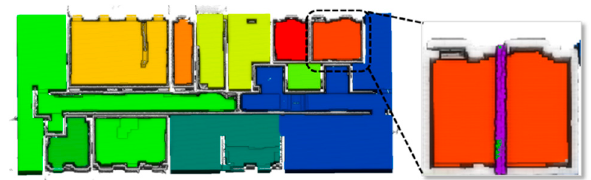
Figure 9. The space subdivisions of PC2 (second epoch) after the change. The purple wall in the right image shows the intersection of a detected change with a space subdivision.